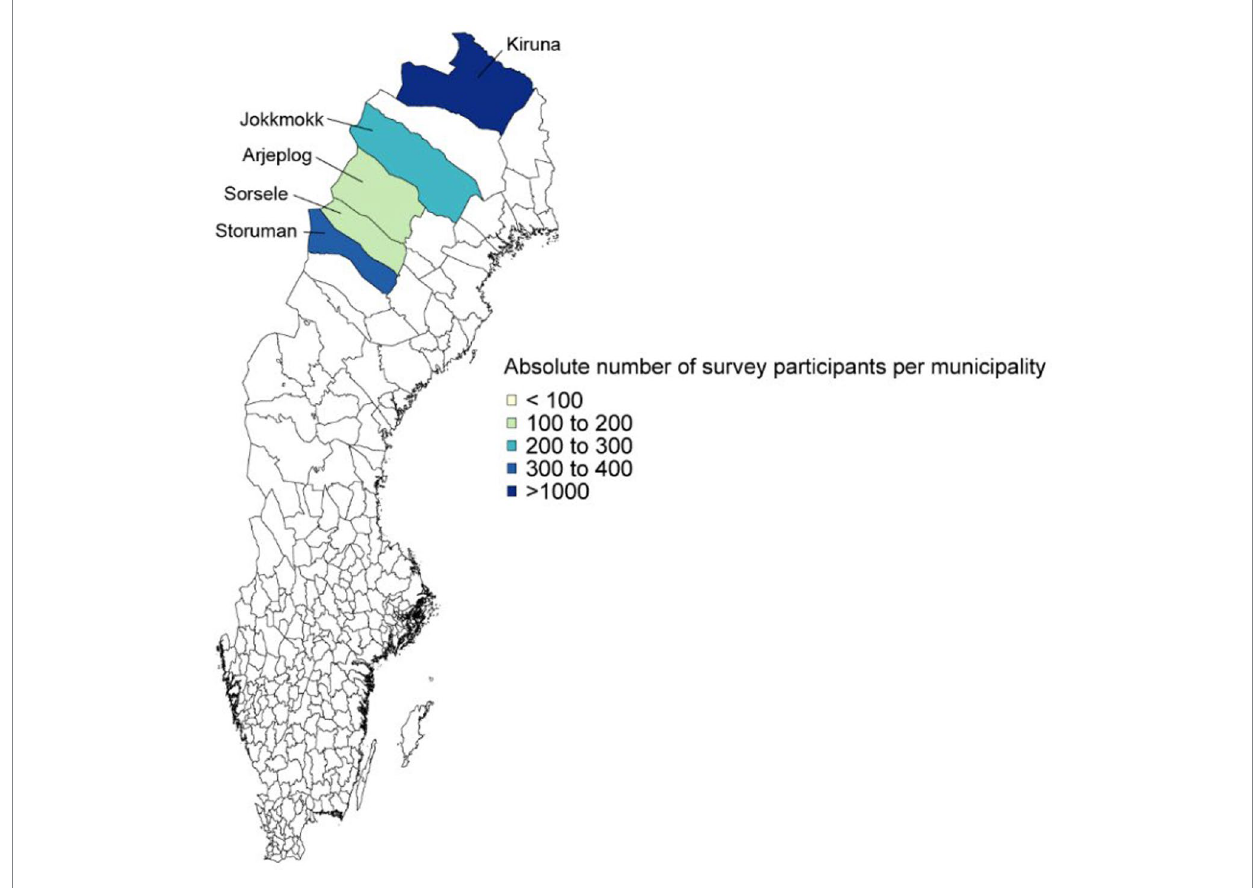
FIGURE 2 Respondent numbers in Sweden.